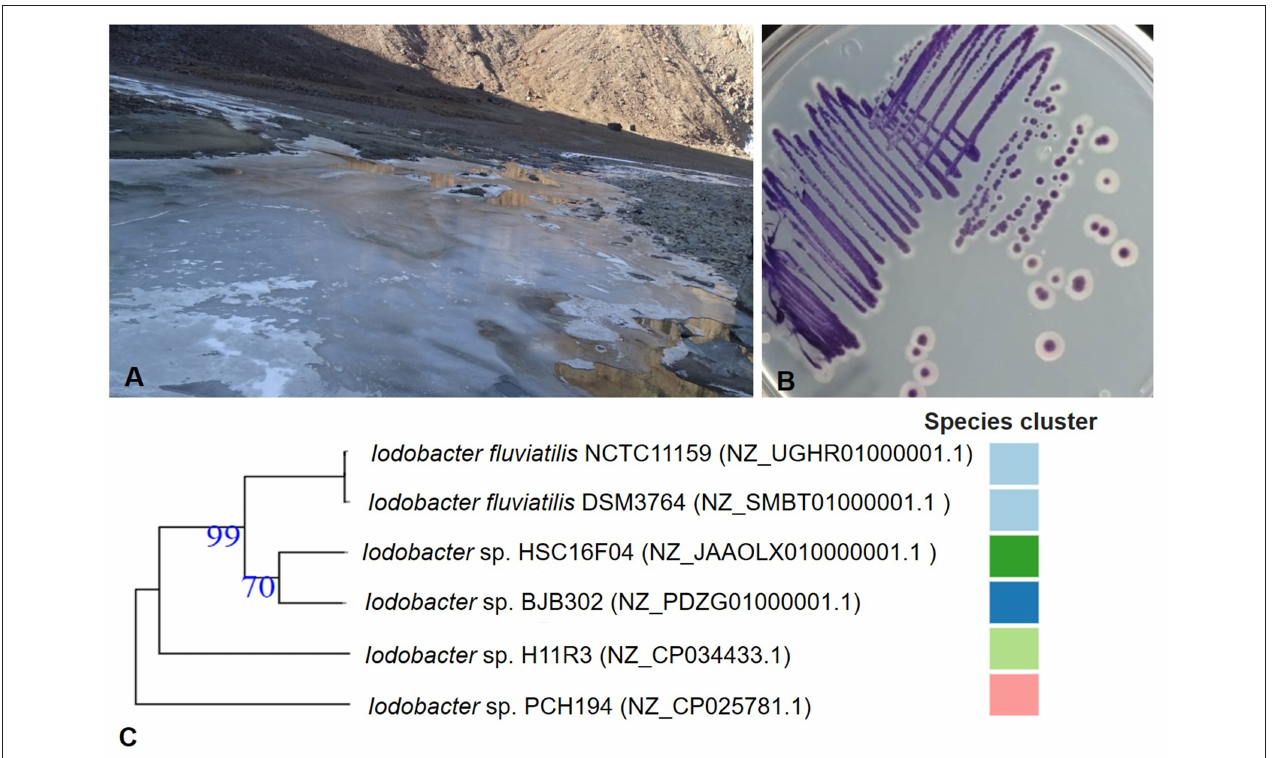
FIGURE 1 | Sampling site and Himalayan bacterium Iodobacte r sp. PCH194. (A) A view of partially frozen kettle lake (Picture was taken on 18 November 2016) at an altitude of 4,160 masl and geographical coordinates of 33.006831 ◦ N, 76.248209 ◦ E at Sach Pass area in Chamba district of Himachal Pradesh, India, (B) isolated single colonies of Iodobacter sp. PCH194, and (C) a phylogenetic tree for genus Iodobacter based on the available whole-genome sequences. The number in parenthesis is the NCBI reference number for the respective genome assembly, and the color code represents the species cluster, where different colors represent the different species. The tree was constructed using an online TYGS server.